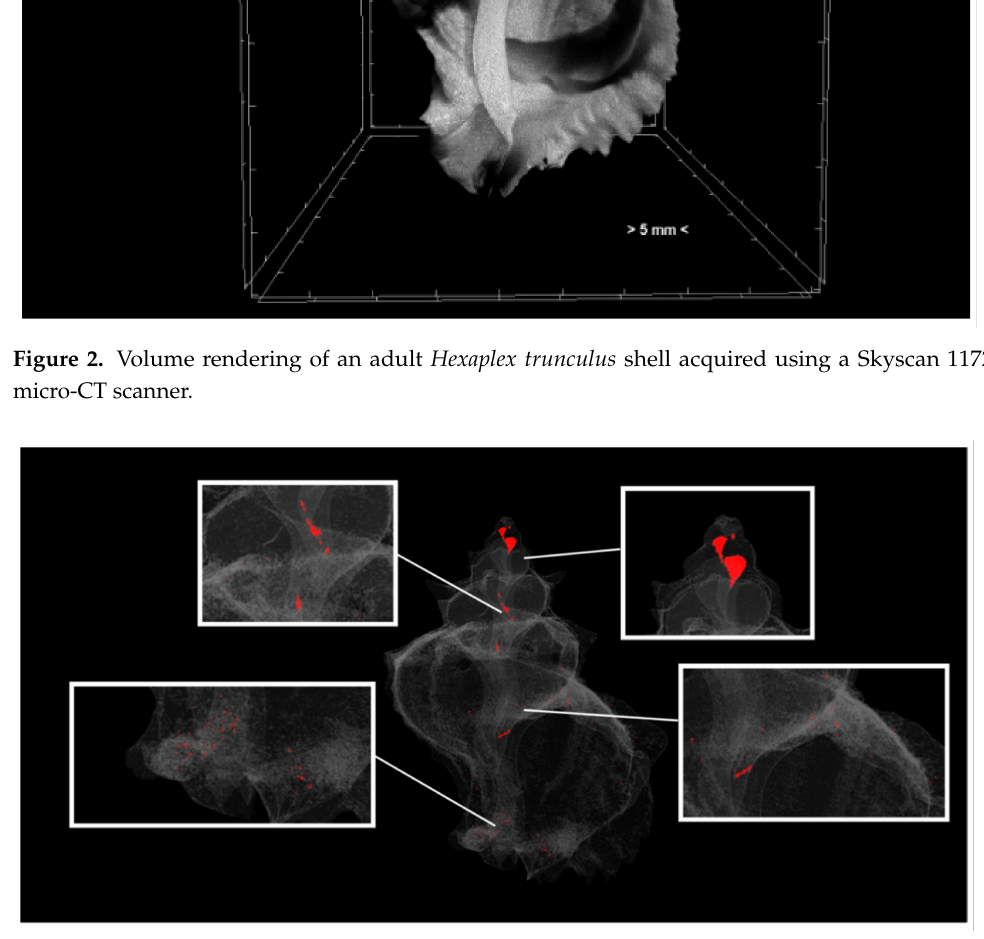
Figure 3. Three-dimensional (3D) model of the closed pores (indicated in red) of an adult Hexaplex trunculus shell (shell length 48.33 mm) acquired using a Skyscan 1172 micro-CT